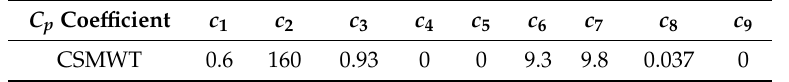
Table 2. Used Betz power coe ffi cients for mathematical calculation of operation parameters.